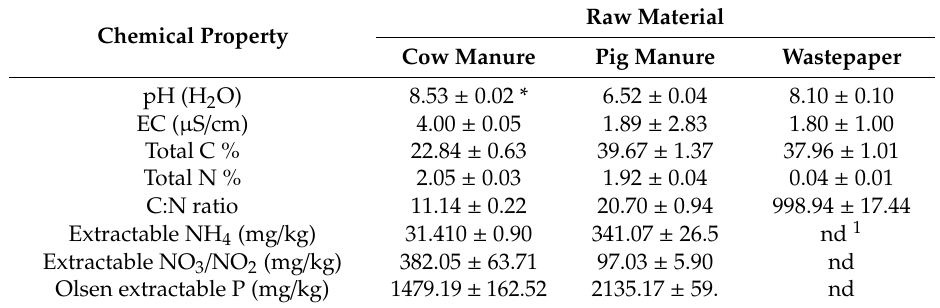
Table 1. Selected chemical properties of the cow manure, pig manure, and wastepaper used in this study. Raw Material Chemical Property Cow Manure Pig Manure Wastepaper pH (H 2